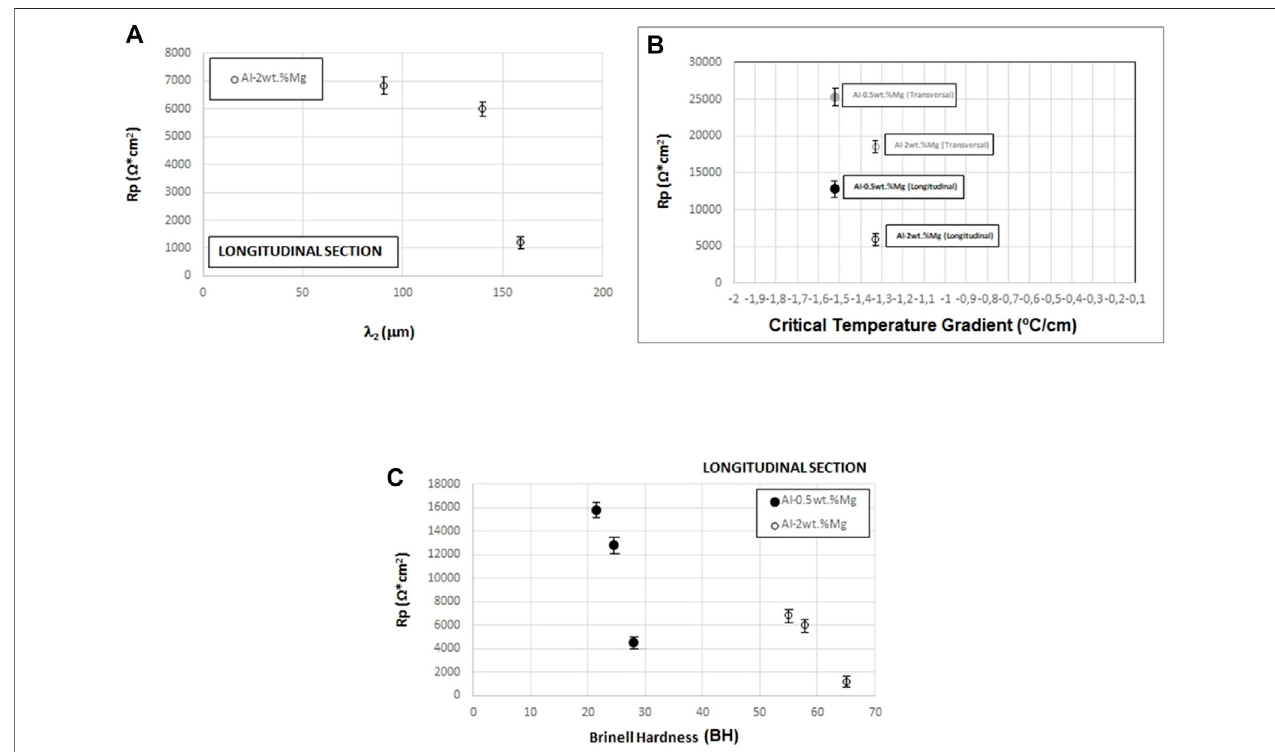
FIGURE12| Polarizationresistance,R p ,versus (A) secondarydendriticarmspacing, λ 2 ,forAl-2wt.%Mgalloy, (B) criticaltemperaturegradient,G C ,and (C) Brinell hardness, BH, for Al-0.5wt.%Mg and Al-2wt.%Mg alloys.